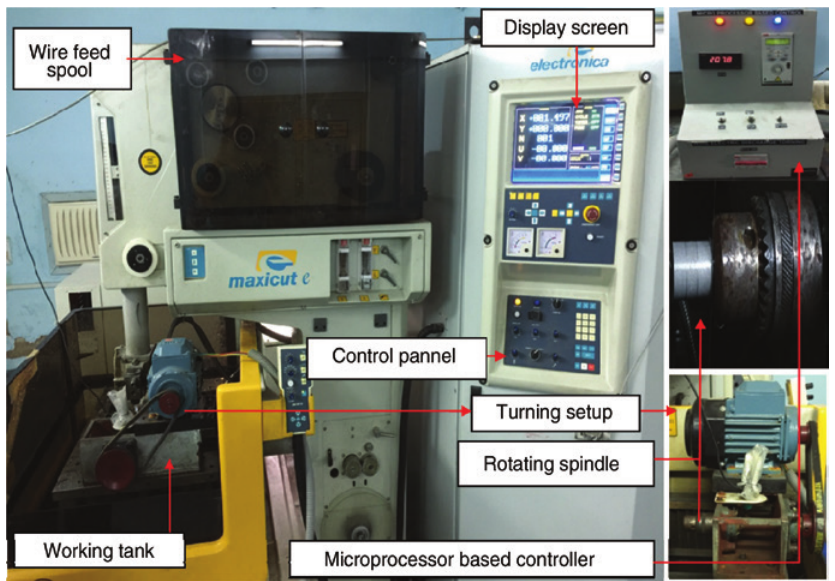
Figure 2: Setup of WED turning